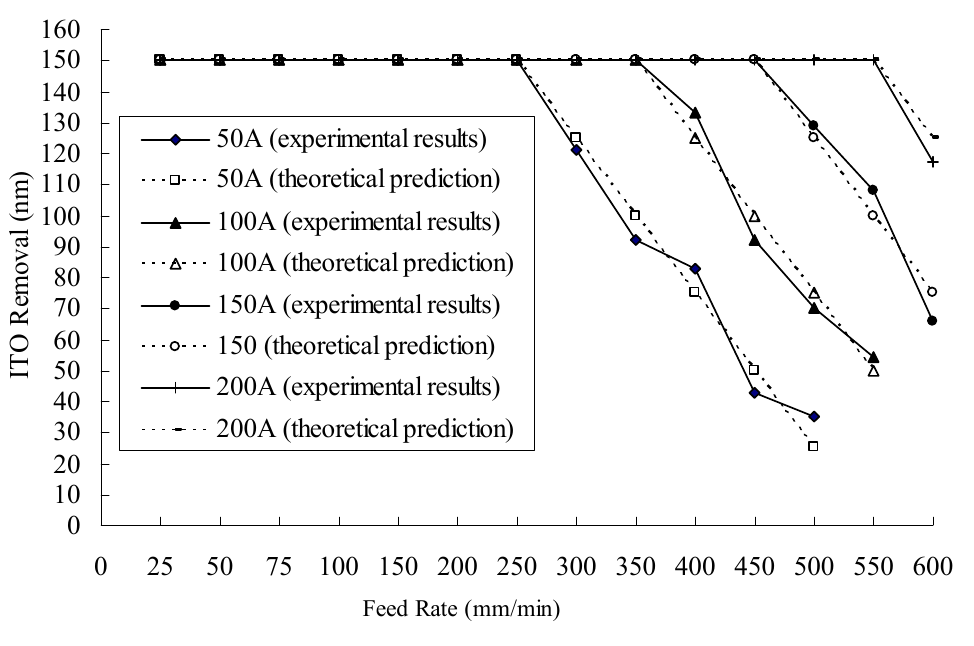
Figure 3. Amounts removed at different feed rates of the workpiece using different current ratings (NaNO of 10 wt% and PO4-3-P 5 wt%, 55 °C, 25 L/min, 300 3